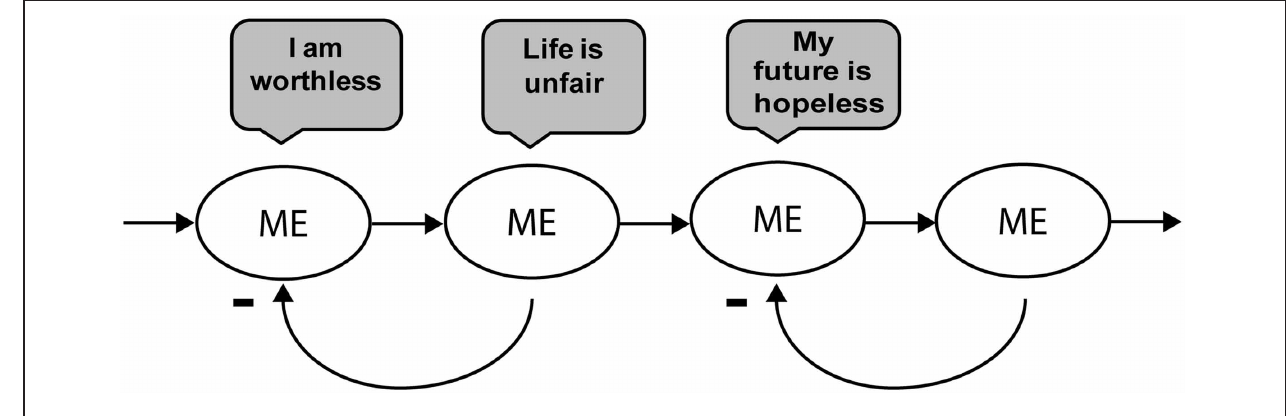
FIGURE 1 | Reification of the dysfunctional narrative self based on Beck’s cognitive triad—a model for psychopathology (Beck, 1976). Dysfunctional attitudes, rumination, and negative self-focus reify the self-narrative for the past, present, and future. The arrows depict